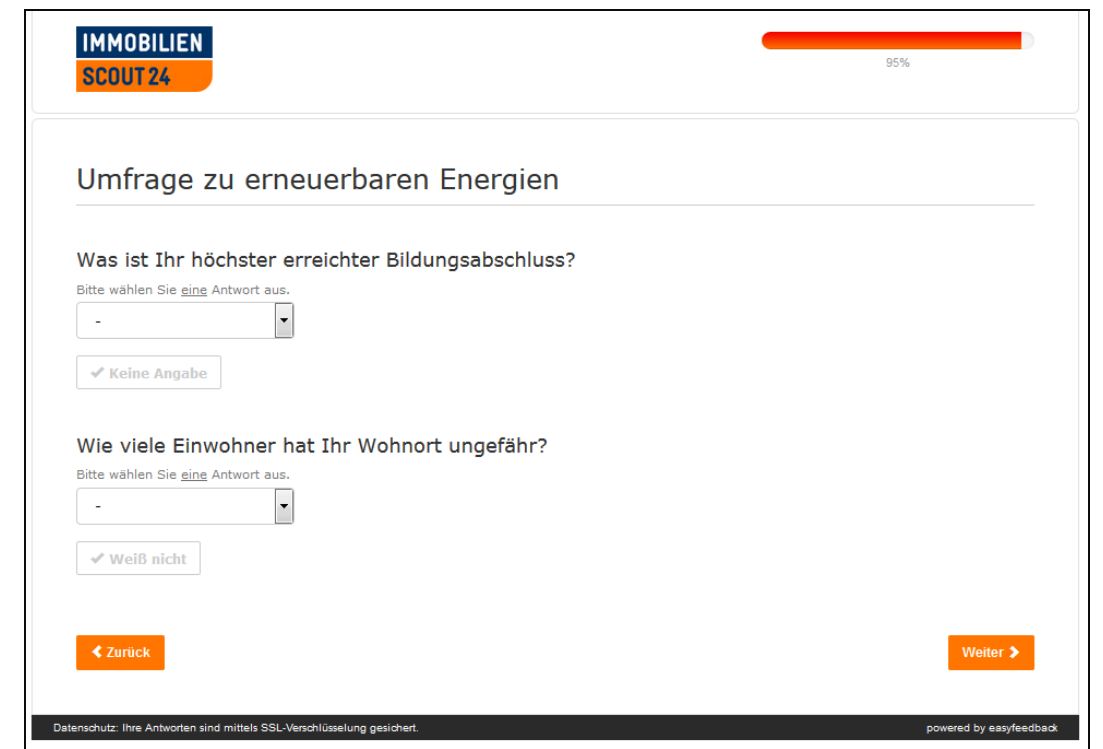
Figure A17. Screenshot of Questionnaire Page 16.